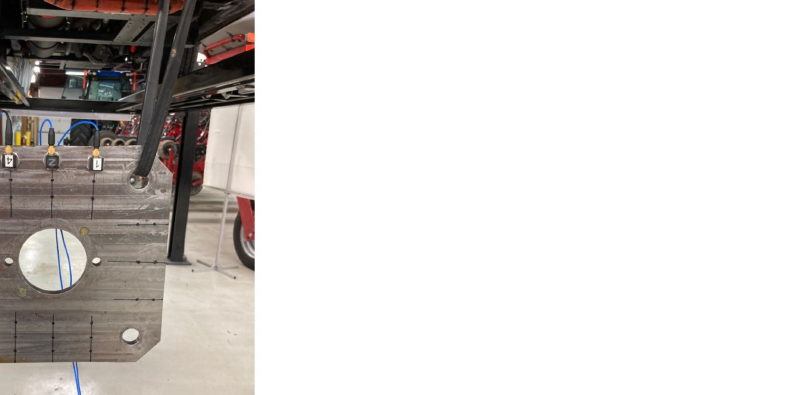
Figure 8. The setup of the experimental modal analysis for each component in free boundary